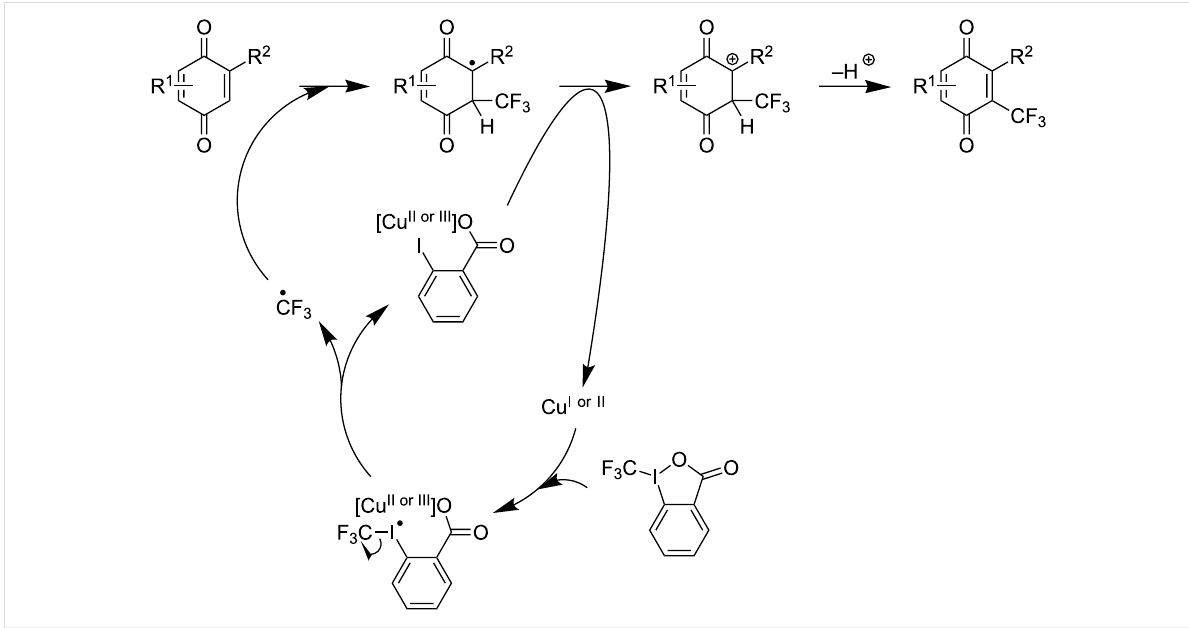
Figure 8: Proposed catalytic cycle by Y. Zhang and J. Wang et al. for the copper-catalyzed trifluoromethylation of quinones [87].